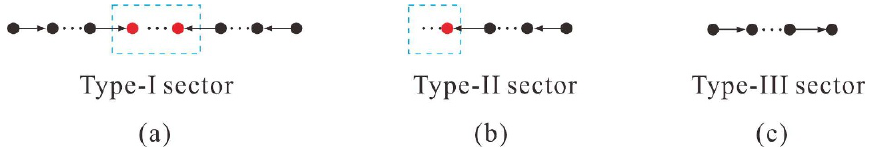
Figure 14 . There are three types of sectors (a), (b) and (c). The starting and internal sectors of the chain (cid:12)gure 13 (a) and the internal sectors of the chain (cid:12)gure 13 (b) have the same general structure (a). Such sectors are called type-I sectors. The starting sector of the chain (cid:12)gure 13 (b) is called the type-II sector and has the pattern (b). The ending sector of any chain has the structure (c) and is called a type-III sector.